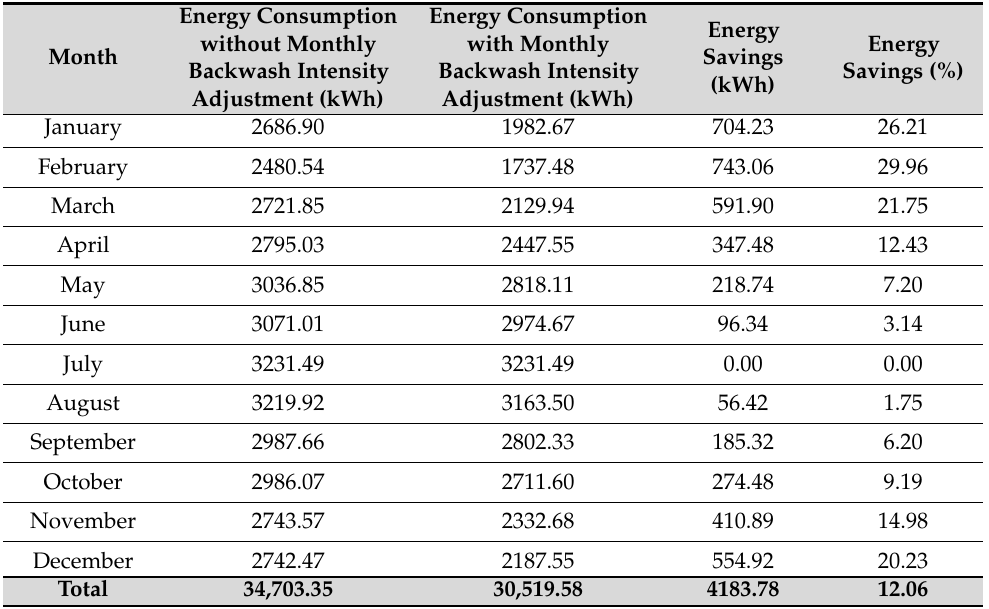
Table 8. Energy savings on backwash rapid filters with monthly adjustment of backwash intensity versus backwash at constant intensity throughout the